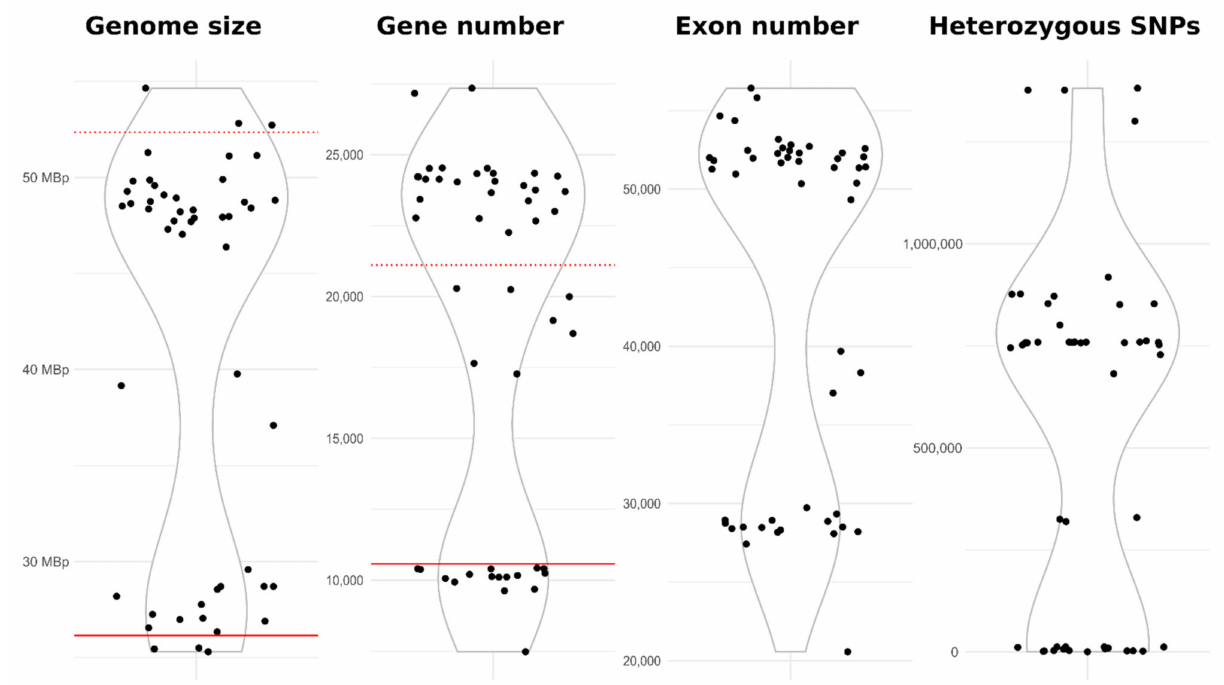
Figure 4. Distribution of genomes based on their size, number of predicted genes, number of exons, and number of heterozygous single nucleotide polymorphisms. The solid horizontal red line marks the value of the (haploid) reference genome, and the dashed horizontal red line marks the double of the reference